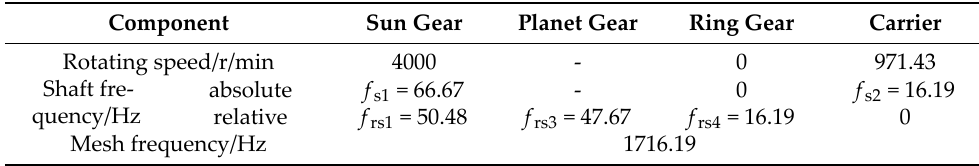
Table 5. Excitation